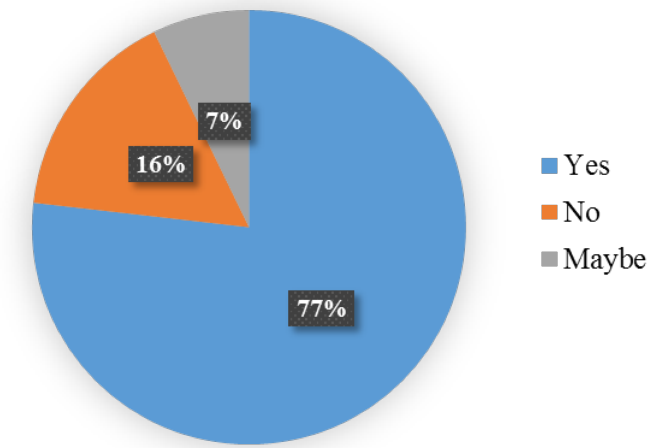
Figure - 14: Showing the school/college/university/institution produce online learning